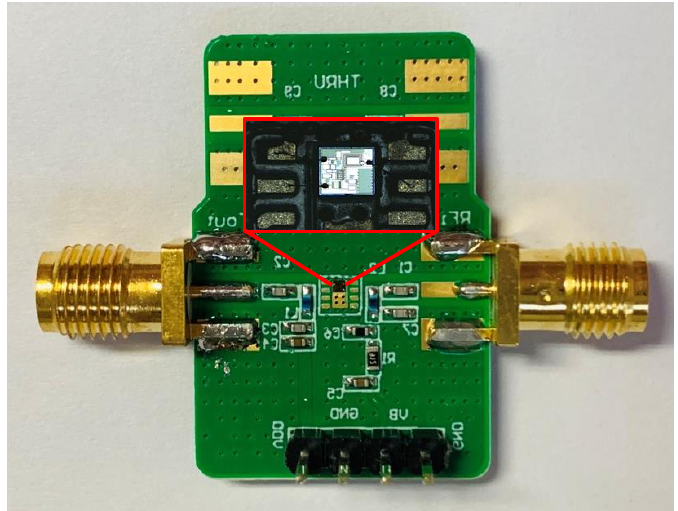
Figure 8. The assembly diagram of the proposed LNA complete circuit.